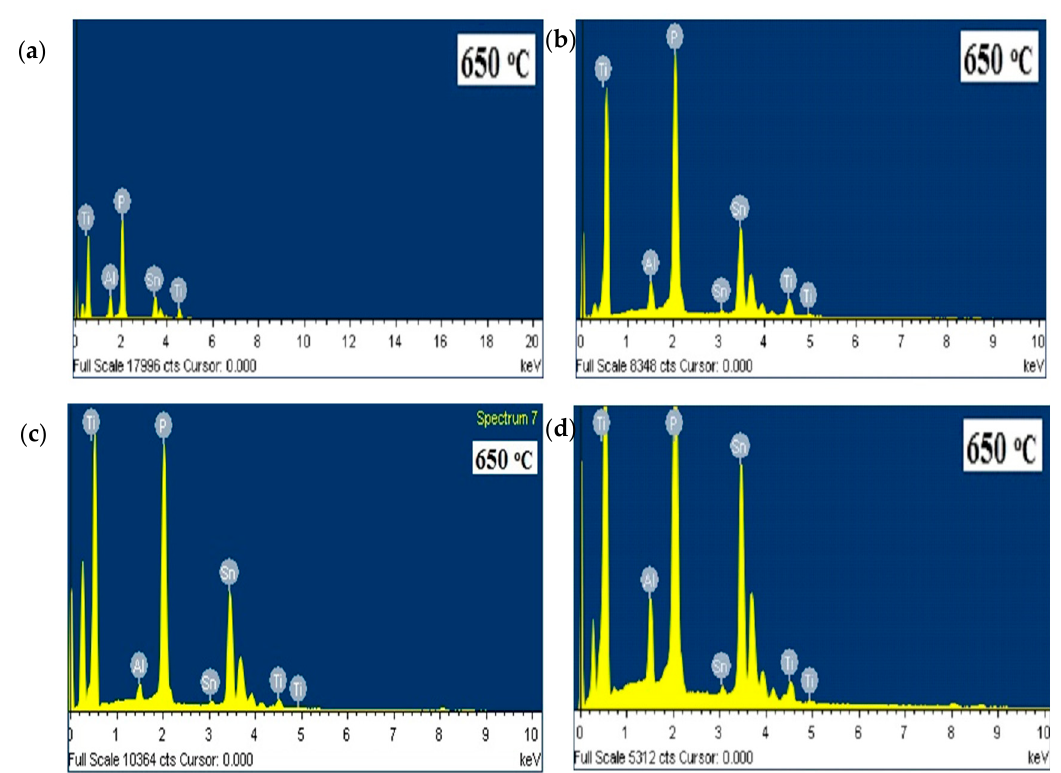
Figure 7. EDX spectrum ofLi 1+x Al x Ti x Sn 2-2x P 3 O 12 with ( a ) x = 0.2, ( b ) x = 0.4, ( c ) x = 0.6 and ( d ) x = 0.8 sintered at 650 °C.